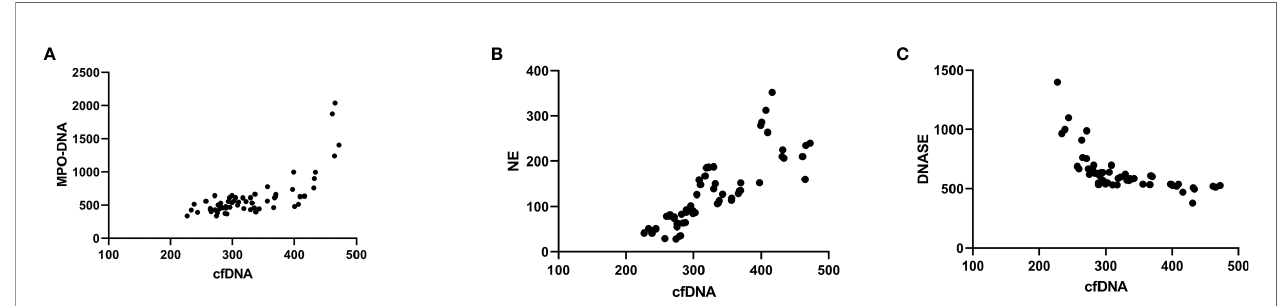
FIGURE 2 | Correlation analysis of MPO-DNA, NE, and DNase with cf-DNA in isolated NETs. Correlation analysis showing that MPO-DNA (A) and NE (B) were highly correlated with circulating cf-DNA levels (MPO-DNA, r 2 = 0.766, P < 0.001, NE, r 2 = 0.687, P < 0.001). The opposite was found between cf-DNA and DNase levels (C) (r 2 = 0.433, P <